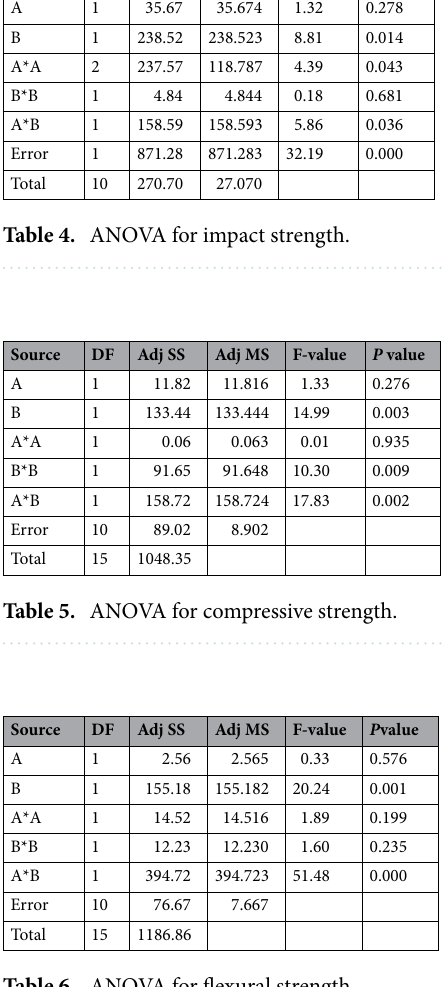
Table 6. ANOVA for flexural